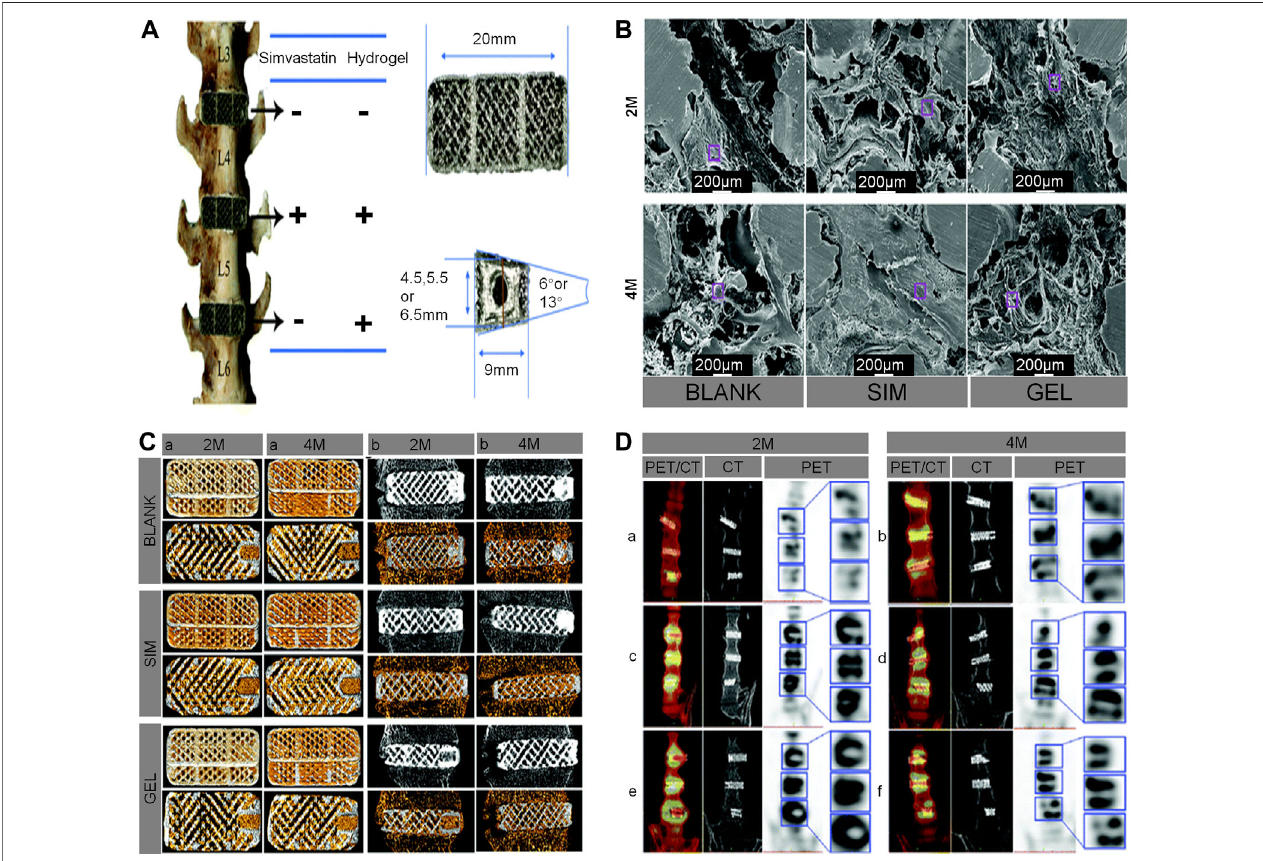
FIGURE8|(A) Thedistributionofthecagesinthelumbarinterbodyspaces,thegeometricalparametersofthecages,andascrewholeincludedononeendofthe cage. (B) Characterization of the intra-porous morphology in cages using scanning electron microscopy, which showed that the bone formation in the cages of the SIM group was very dense. (C) Bone ingrowth in the cages (yellow represents new bone) at 2 and 4 months. For each cage in the different fused segments, the upper panel shows 3D-reconstructedimagesofthecages, and thelowerpanel showsaxial2-dimensional imagesofthecages (A) .Osseointegrationaroundthecages(grayin the upper panel and yellow in the lower panel both represent new bone in cages) (B) . (D) Coronal fused positron emission tomography/CT, CT, and positron emission tomography and a locally enlarged image of the macaques at 2 and 4 months, respectively (Zhang et al.,